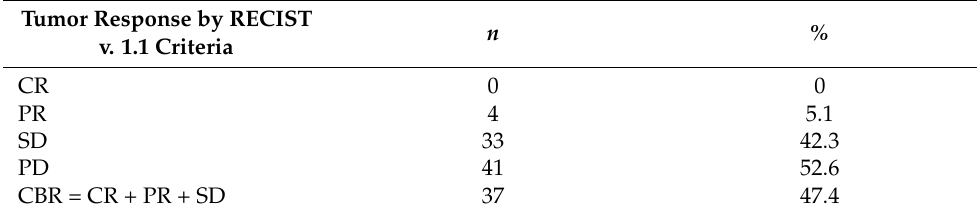
Table 2. Response in patients by RECIST v.1.1 criteria ( n = 78).